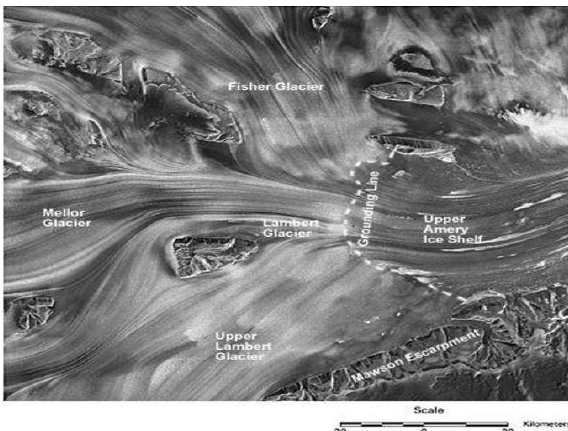
Figure 1. Location of study area (source: https://nsidc.org